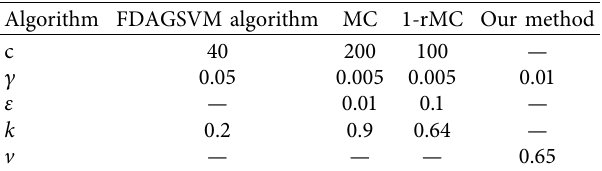
Table 2: Algorithm parameter settings.